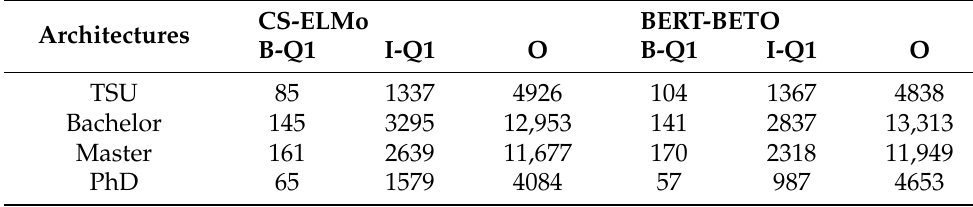
Table 7. Detection results for question Q3: How is it going to be done?